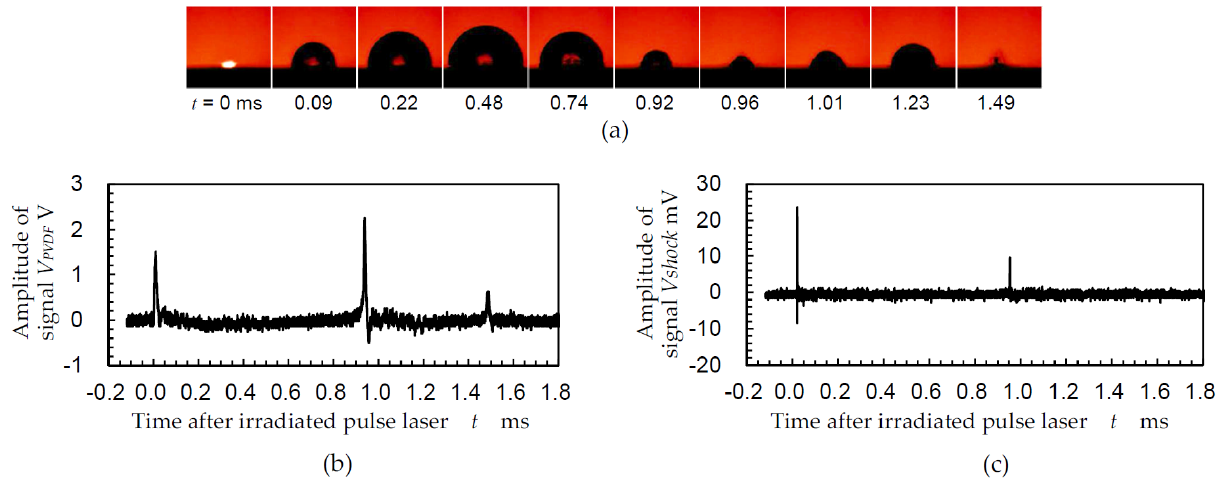
Figure 2. Laser ablation (LA) and laser cavitation (LC) produced by pulse laser of λ = 532 nm. ( a ) LA and LC observed through neutral density filter; ( b ) signal from a polyvinylidene fluoride (PVDF) sensor; ( c ) signal from submerged shock- wave sensor.